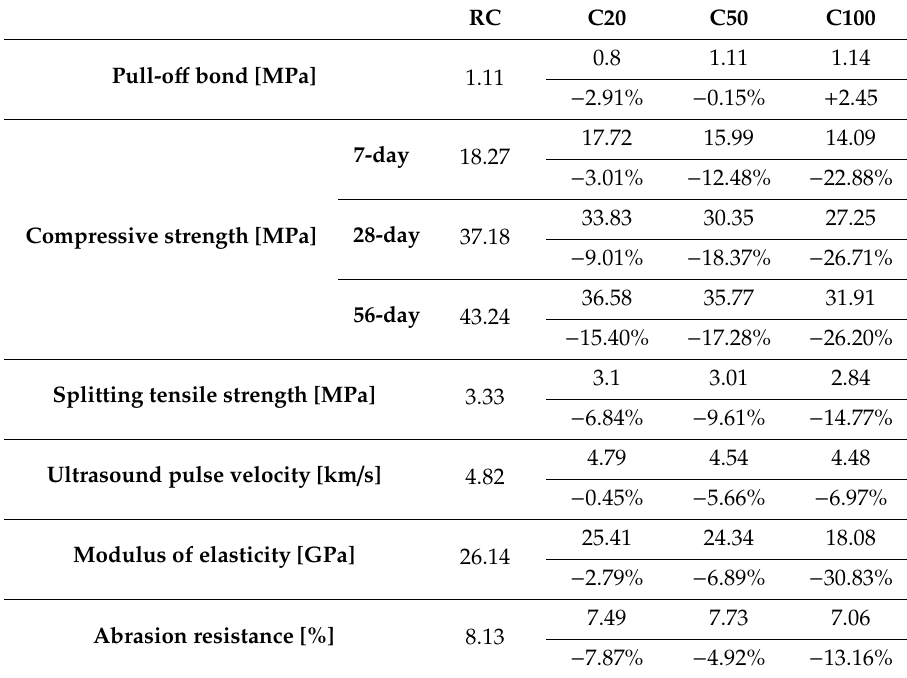
Table 4. Mechanical properties of shotcrete mixes (adapted from Duarte et al.